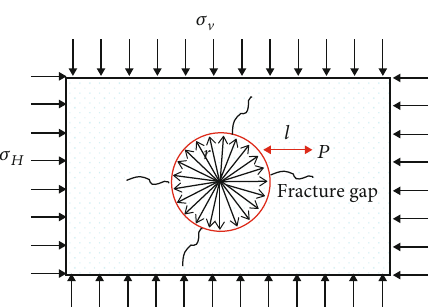
Figure 4: Mechanical model of crack initiation under hydraulic